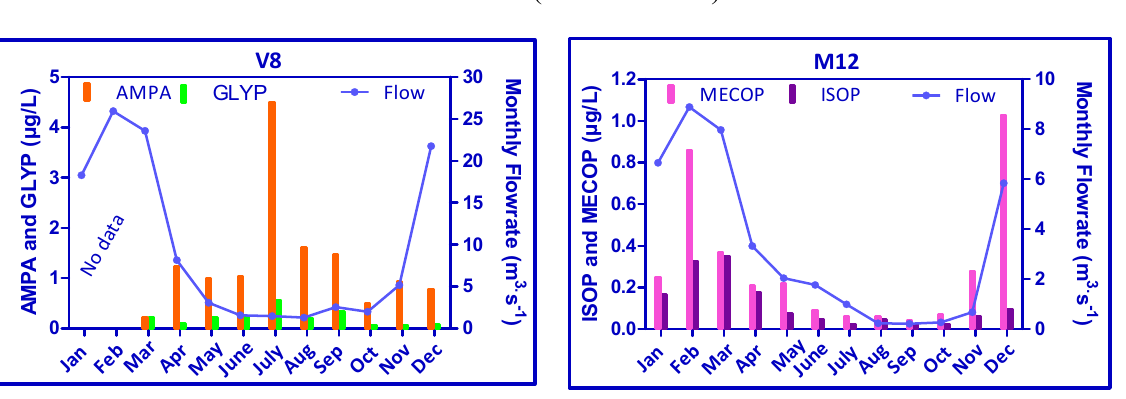
Figure 6. Evolution of monthly flow rate and monthly concentrations of AMPA, GLYP, MECOP and ISOP on urban and rural areas (historical